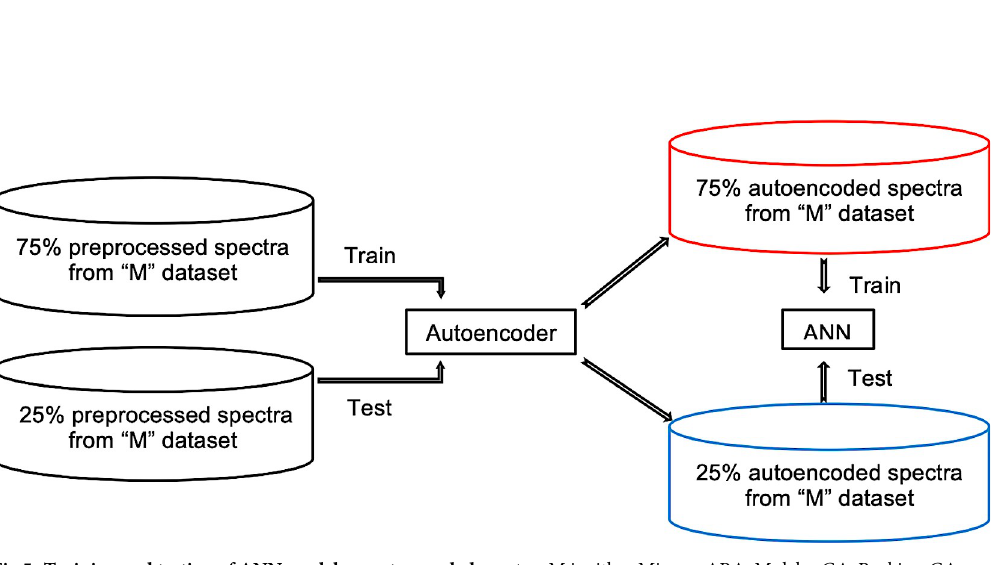
PLOS ONE | https://doi.org/10.1371/journal.pone.0234557 June 18, 2020 7 /